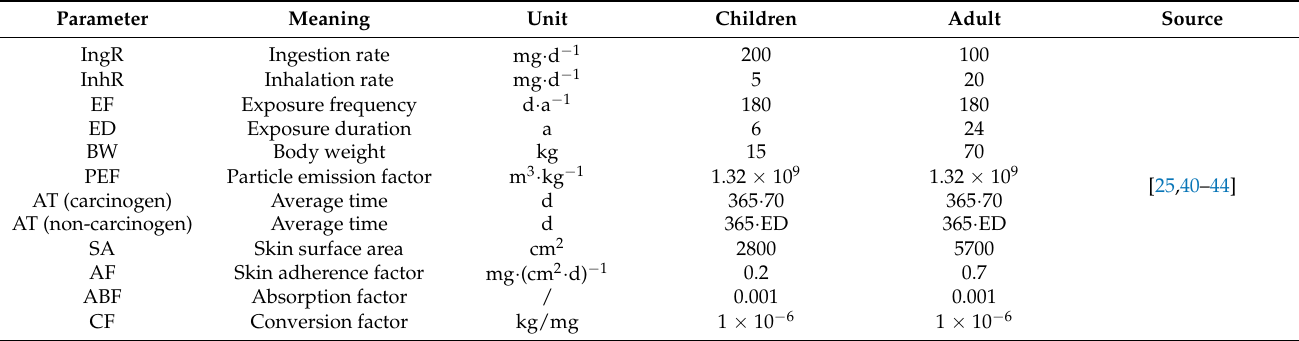
Table 3. Exposure parameters for health risk assessment